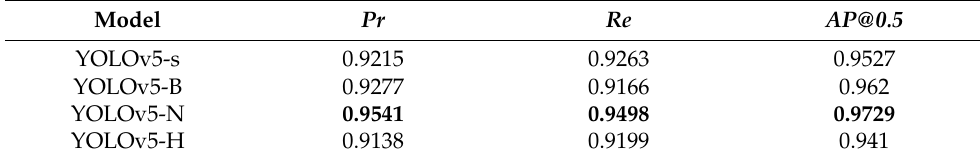
Table 3. Comparison of results of fusion CA.